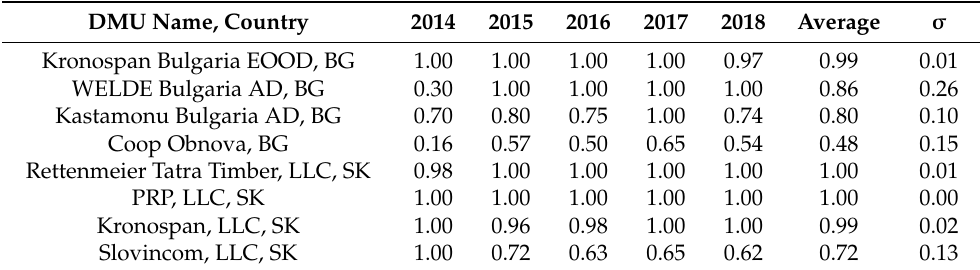
Table 3. CCR scores for DEA with labour and depreciations inputs.